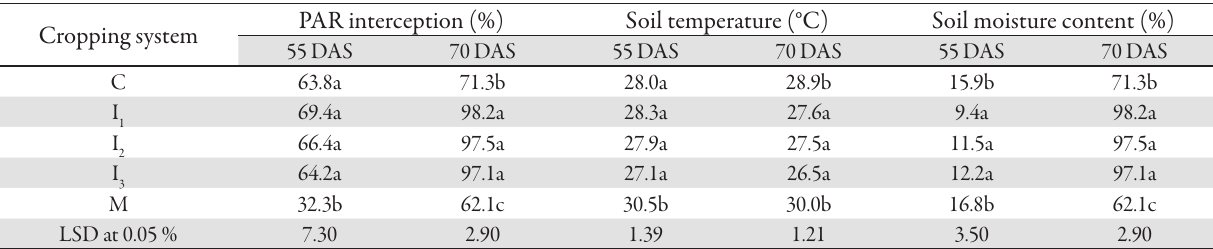
Tab. 1. Effect of different cropping system on PAR interception, soil temperature and soil moisture content Cropping